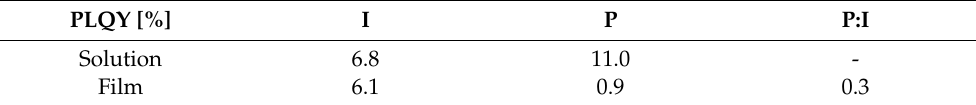
Table 3. PLQY of studied